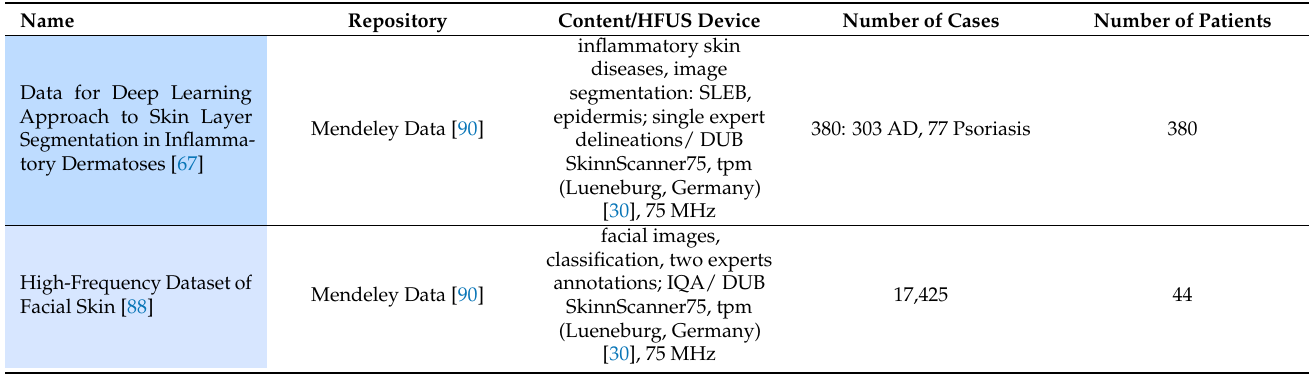
Table 11. HFUS image datasets available in the public